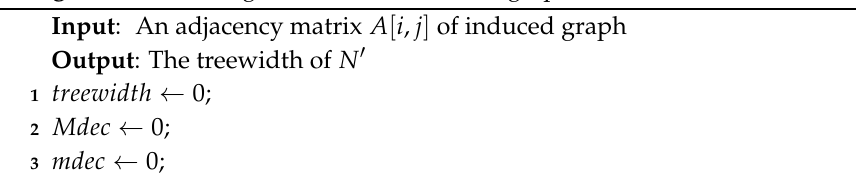
Algorithm 1: solving treewidth of included graphs of CP-nets N (cid:48)